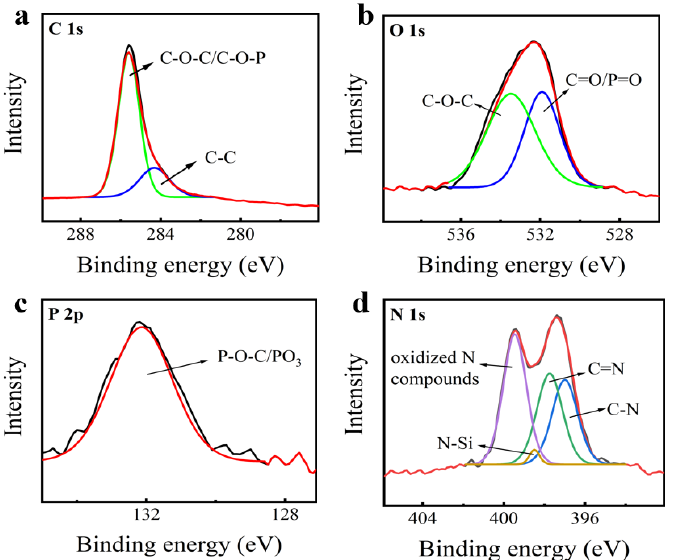
Figure 9. High resolution XPS spectra for ( a ) C 1s; ( b ) O 1s; ( c ) P 2p; and ( d ) N 1s of the char residue of the DOPO-M-rGO/EP composite.